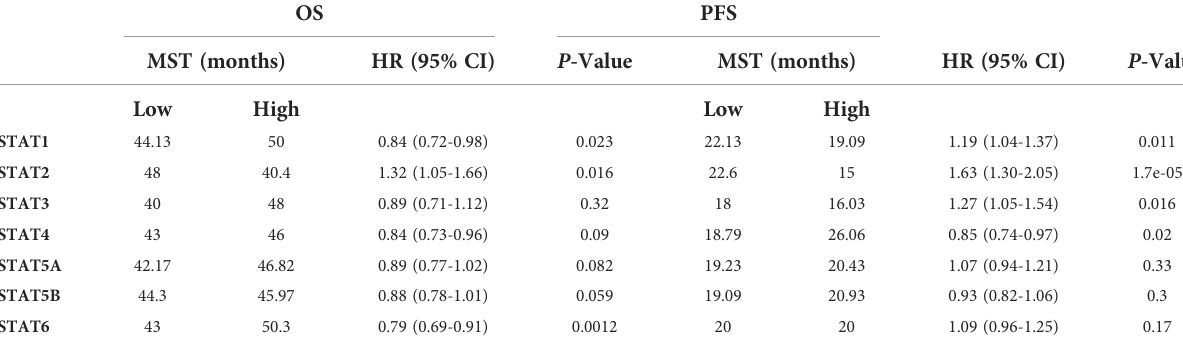
TABLE 1 Correlation between the expression of STATs and OS or PFS in ovarian cancer